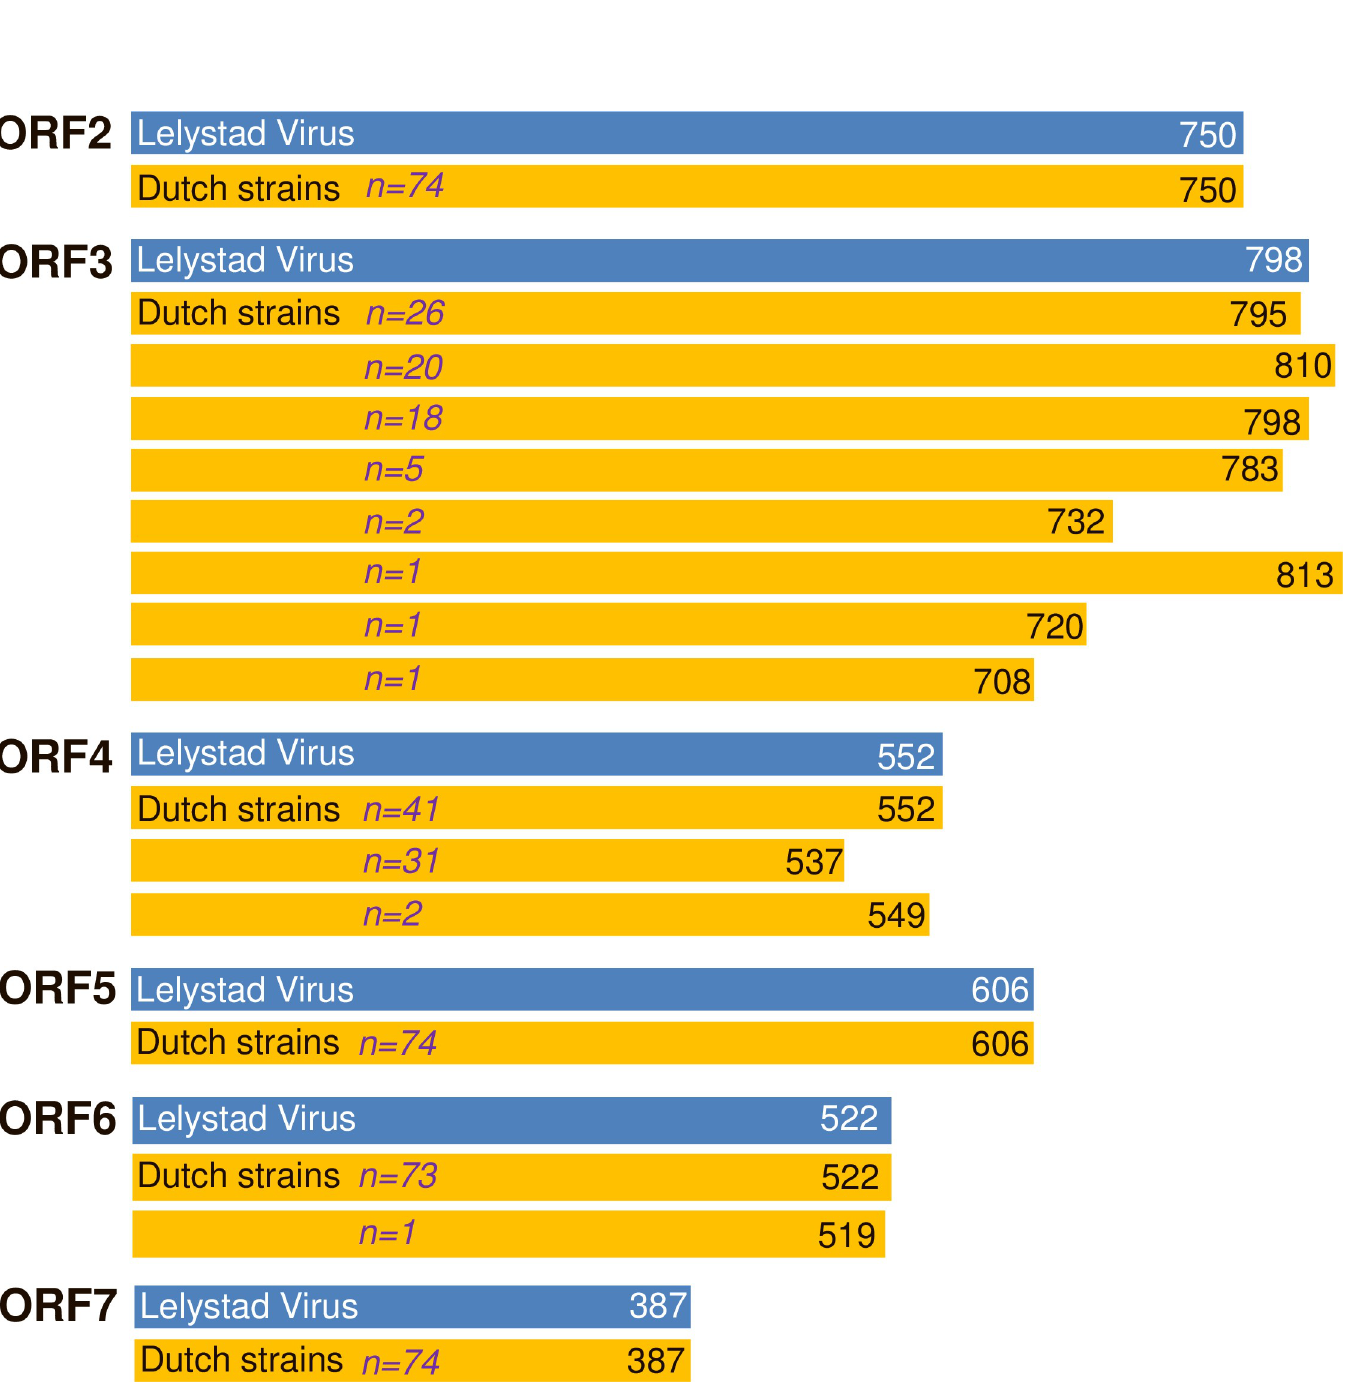
Fig 1. Phylogenetic analysis. Dutch ORF2-ORF7 sequences isolated in 2014–2016 (blue) were compared with representative PRRSV-1 sequences available in GenBank (black). GenBank accession number is given, as well as country/identifier/year, if available. The tree is rooted with type 2 strain VR2332 (PRU87392). The percentage of trees in which the associated taxa clustered together is shown next to the branches (only > 50).